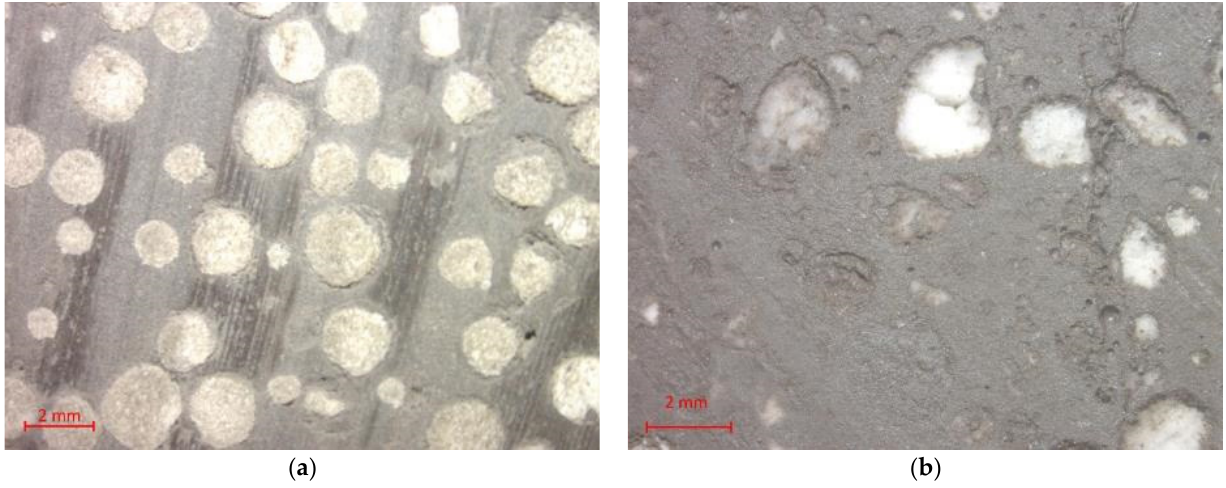
Figure 5. Stereoscopic images for geopolymer samples containing: ( a ) containing 3% wt. EPS and ( b ) 15% wt. ExP.